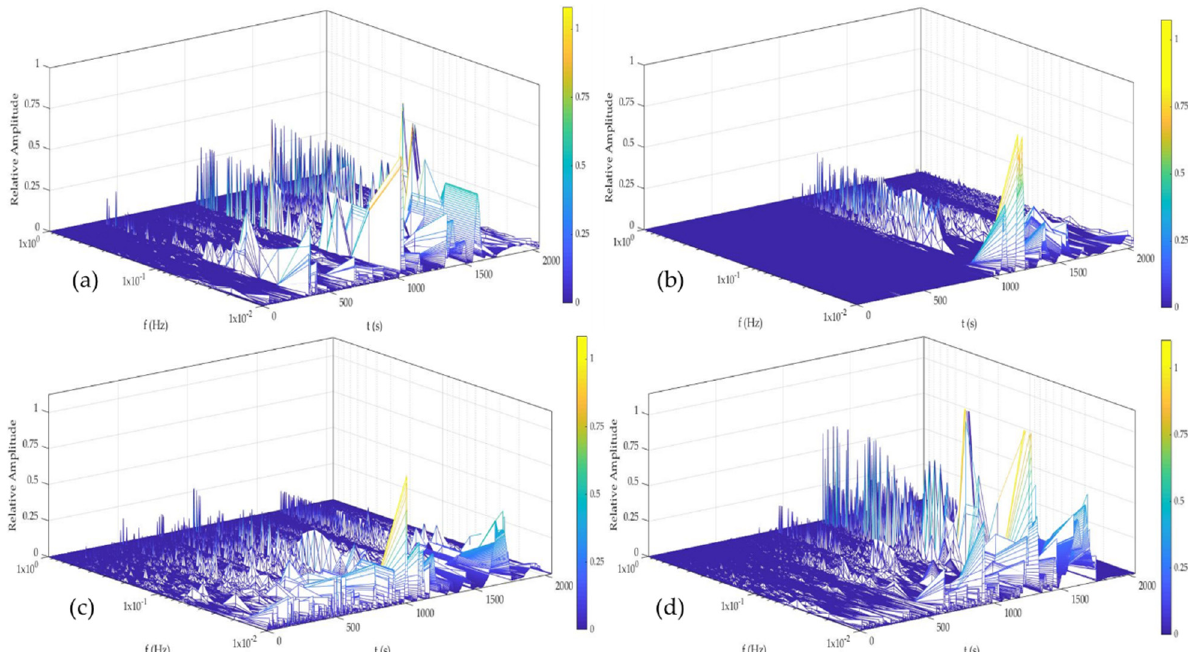
Figure 17. Hilbert spectra of Al-A.M. in NaCl solution ( a ) 0 h, ( b ) 24 h, ( c ) 48 h, and ( d ) 120 h.